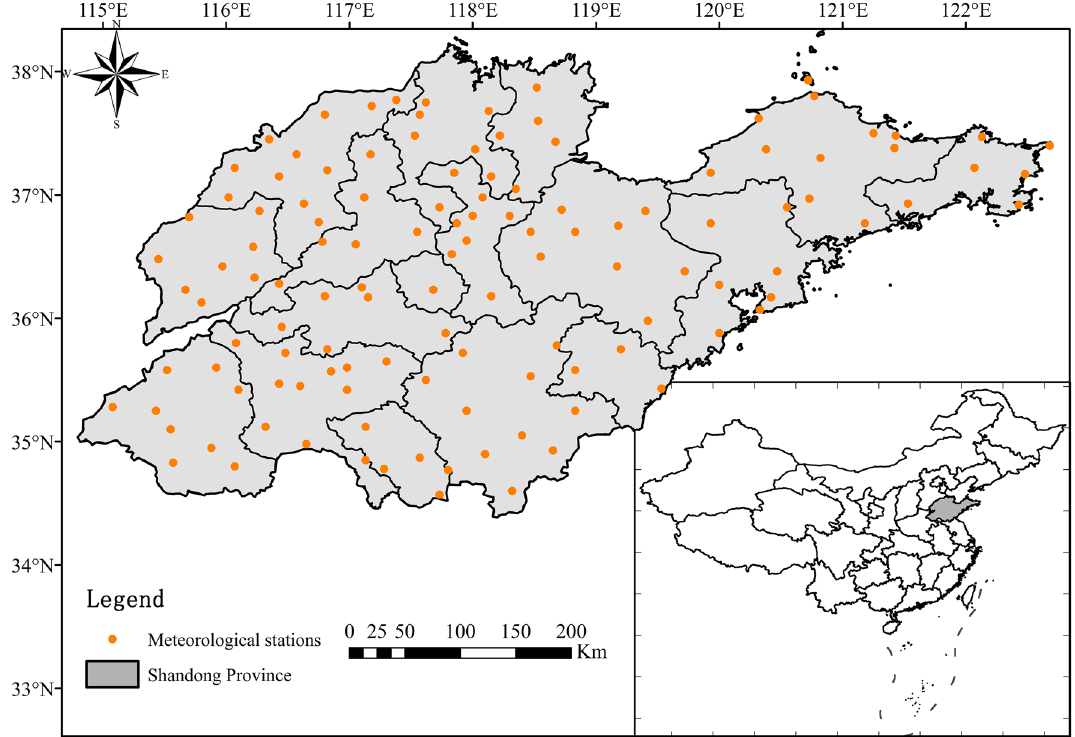
Figure 1. Location of meteorological stations and Shandong Province (The software used to create the maps in Figs. 1, 3 and 4 is ArcGIS10.4, URL: http:// gisse rver. domain. com: 6080/